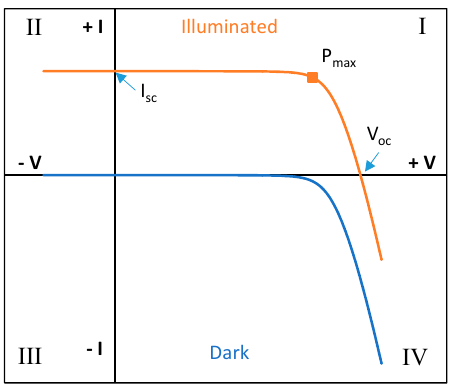
Figure 2. Illuminated and dark I-V curve of a PV device. Characteristic points are shown.